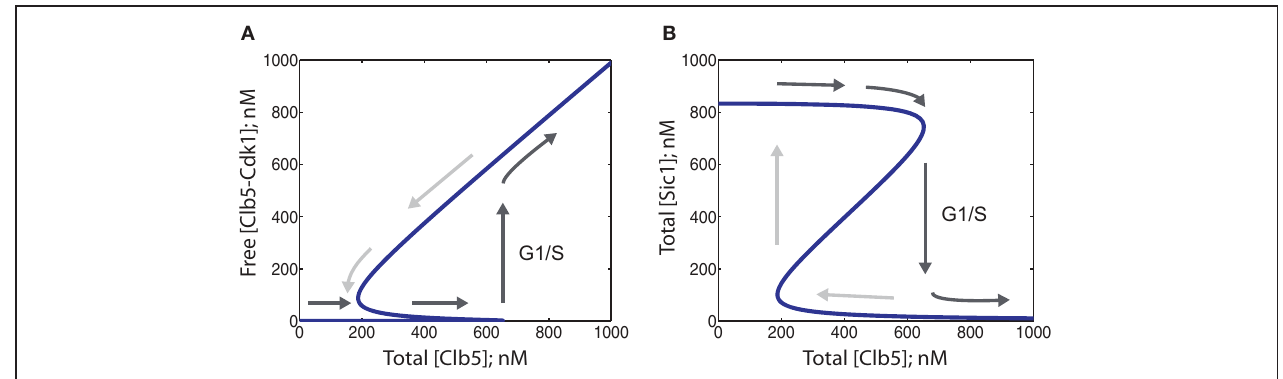
FIGURE 4 | Phase diagrams showing the bistability of the system at steady state. Parameter values are provided in Table 1 . The dark gray arrows show possible paths for a gradual increase of free Clb5-Cdk1 while entering the S-phase, and possible reversible paths (light gray arrows) in the event of stochastic decreases in Clb5 levels. (A) Phase diagram showing the dependence of free Clb5-Cdk1 activity on total Clb5-Cdk1 levels. When a